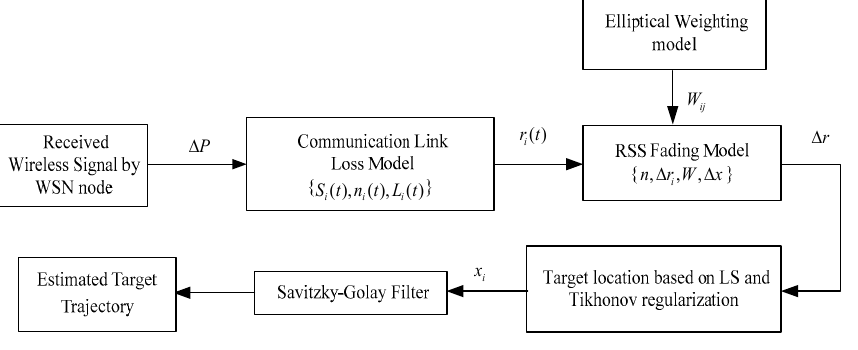
Figure 1. Radio tomography imaging (RTI) sensor node deployment.